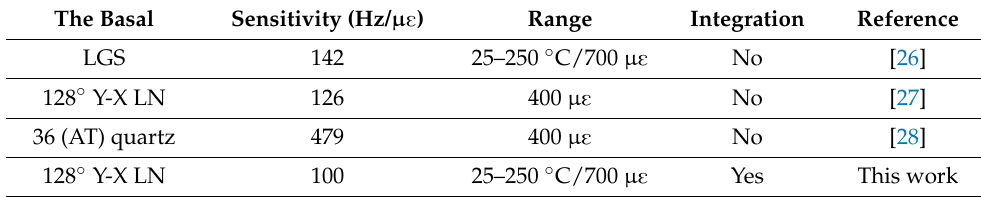
Table 1. Comparison between the sensors we studied and previously reported